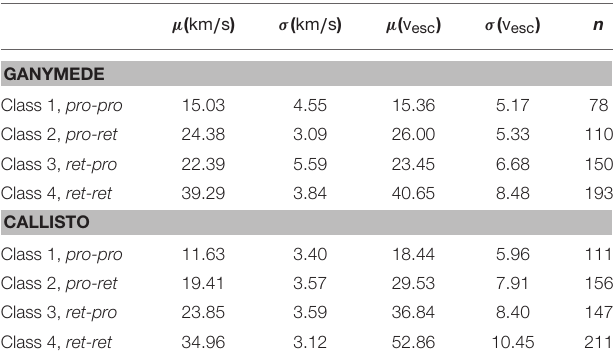
TABLE 2 | Mean and standard deviations of close encounter velocities for the four classes, as well as their